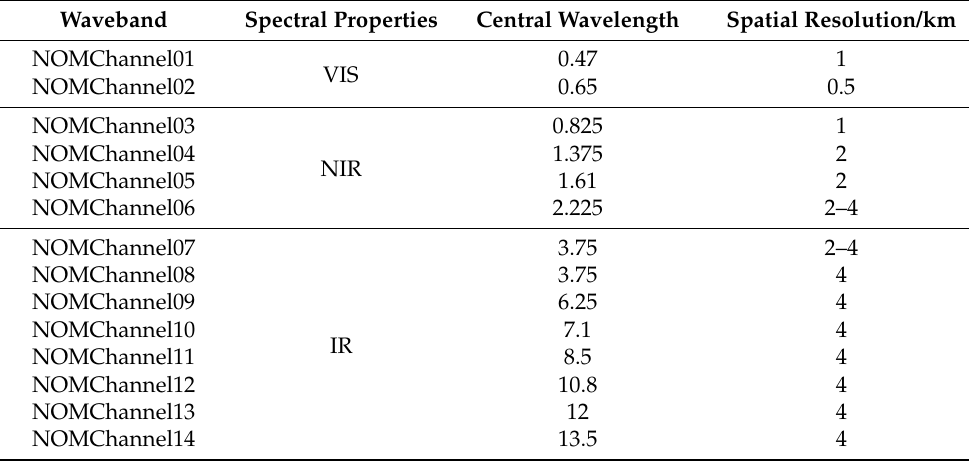
Table 2. The main technical parameters of FY-4A AGRI.